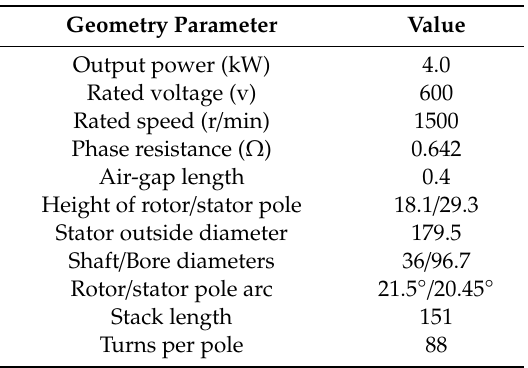
Table 1. The design data of the 8 / 6 switched reluctance motor (SRM) prototype in mm